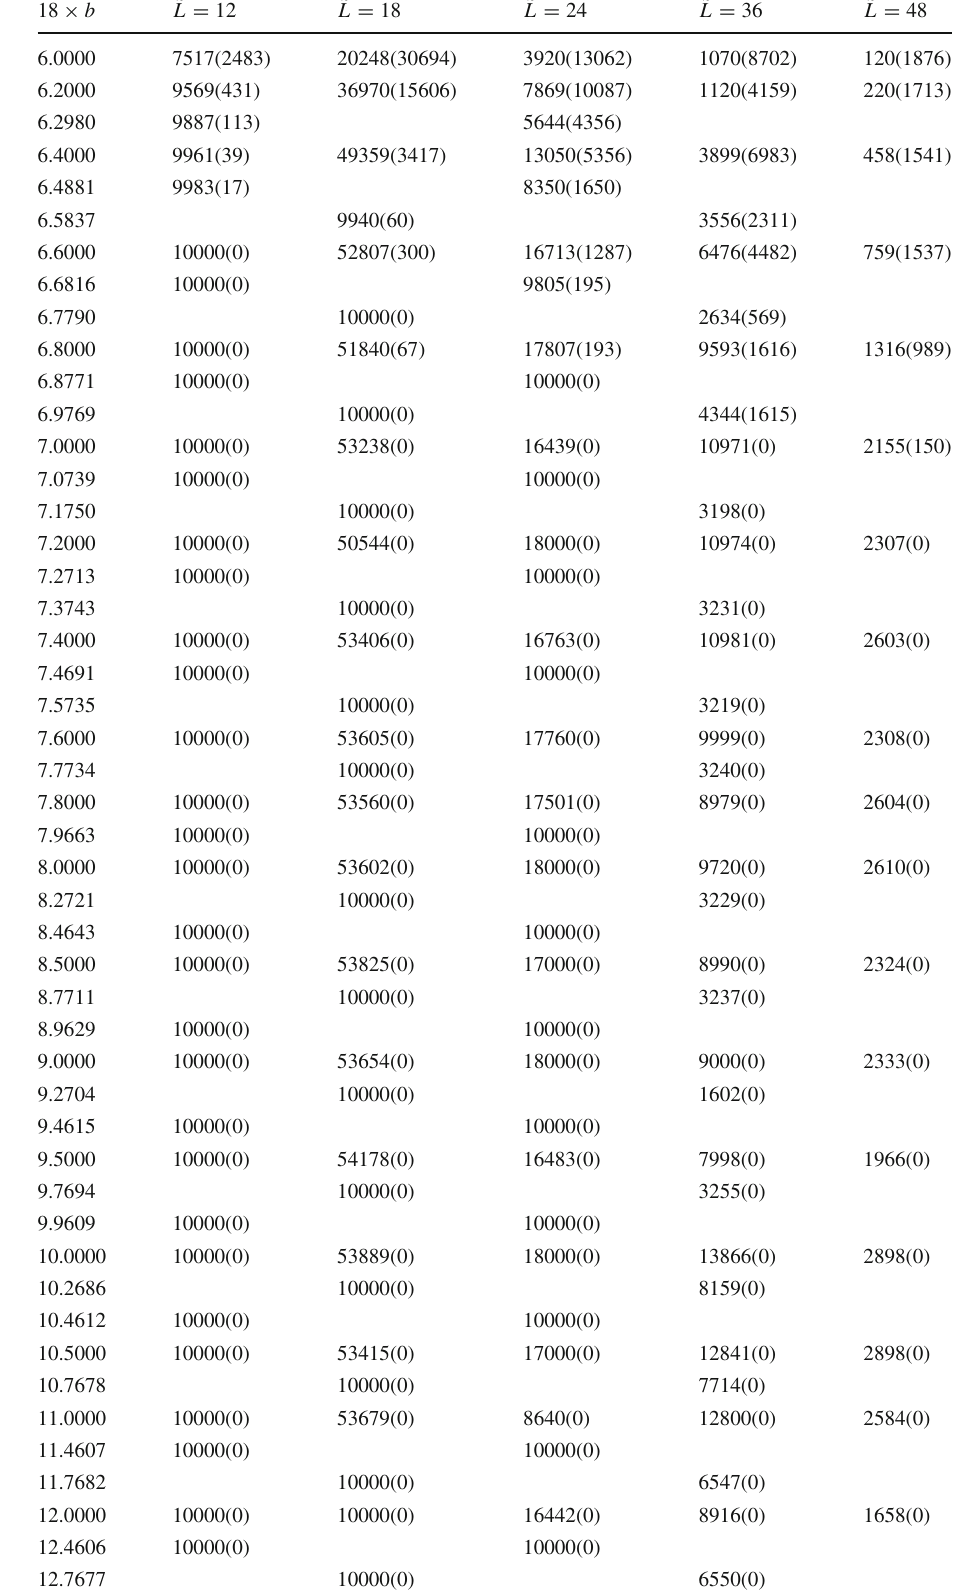
configurations with zero topological charge (within parenthesis those with non-zero